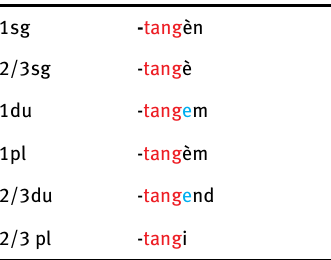
Table 11: Imperfect inceptive